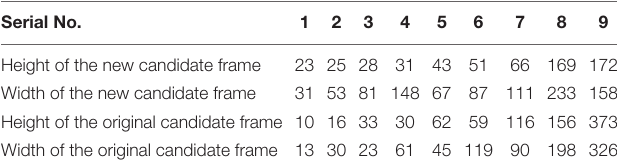
TABLE 1 | Parameters of candidate frames for multiple features of bananas. Serial